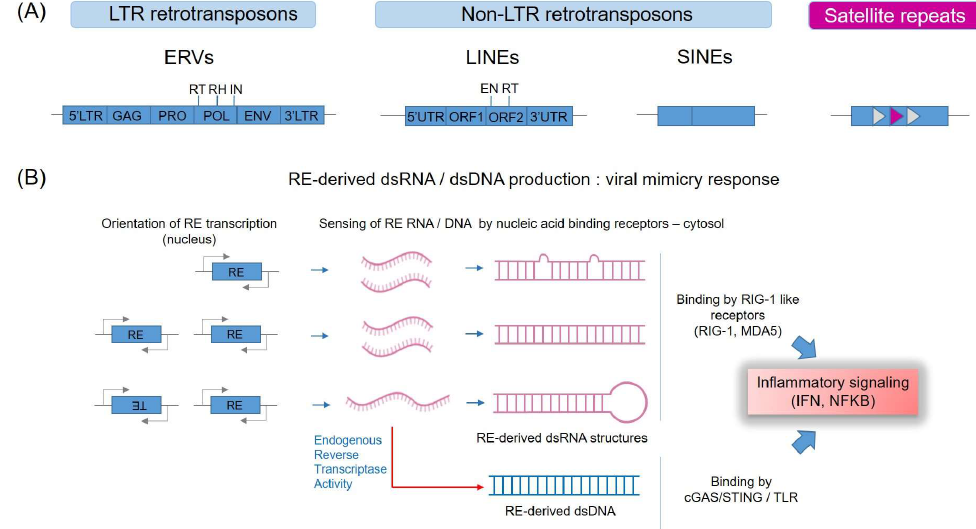
Figure 2. Viral mimicry initiation. ( A ) Endogenous retrotransposon element (RTE) classes and satellite repeats. Transcripts derived from families of endogenous retroviral elements (ERV) (LTR retrotransposons), non-LTR retrotransposons (LINEs, SINEs which are polyadenylated, not shown) and satellite repeats have been implicated in the viral mimicry response. The RTE encode overlapping Gag (capsid protein), Pro (protease), Pol (polymerase), and Env (envelope) ORFs (open reading frames), although many human ERVs lack envelope proteins and multiple germline mutations have inactivated ORFs. In contrast, some human LINEs and SINE families are mobile due to L1 ORF1p and ORF2p activity that targets both young LINE and SINE RNAs for retrotransposition (readers can see a review for further details [24]). Amongst other features, Pol incorporates reverse transcriptase (RT), ribonuclease H (RH), and integrase (IN) activities, as depicted. ( B ). Endogenous retroelement (ERE) transcripts can form dsRNAs. dsRNAs can form in trans through bidirectional transcription of a single RTE locus or through RNAs transcribed from the same or similar elements from different loci, where dsRNAs can form through imperfect base pairing, as indicated. dsRNAs can also form in cis through transcription of inverted-repeat (IR) elements with a single transcript, and subsequent base pairing to form a stem loop dsRNA structure. Endogenous reverse transcriptase activity can convert target RT or other RE RNA to dsDNA. These nucleic acids can trigger the viral mimicry response by PRR (pathogen pattern recognition receptors) leading to NFκB and interferon inflammatory signaling; dsRNA products are recognized by RIG-1-like receptors, as indicated. By contrast, dsDNA products are recognized and trigger signaling by the cGAS/STING/TLR PRR, as indicated (figure adapted from, [3]).